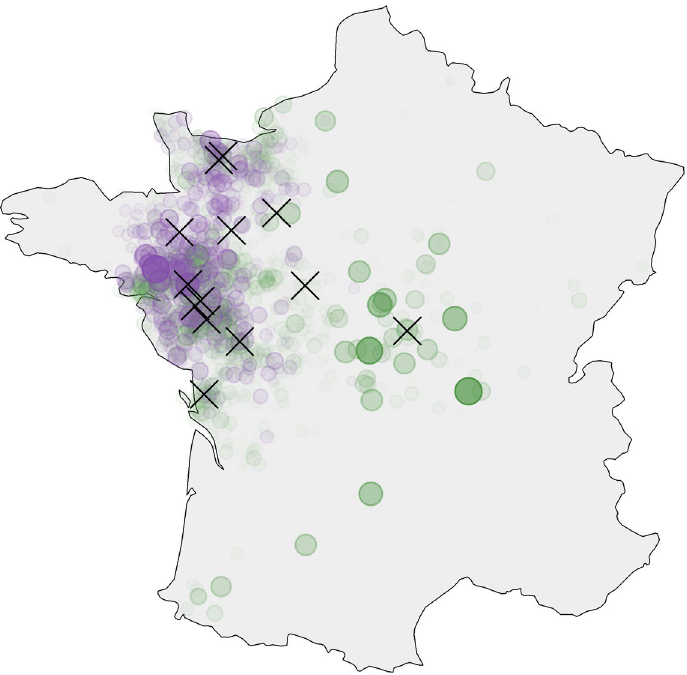
Figure 3. Geographic distribution of the sorting centres (black crosses), calf-cow producers (green circles) and fatteners (purple circles) of the historical database ( Terrena Production Bovine ) in metropolitan France. The size of the circles is proportional to the number of animals coming from or going to each